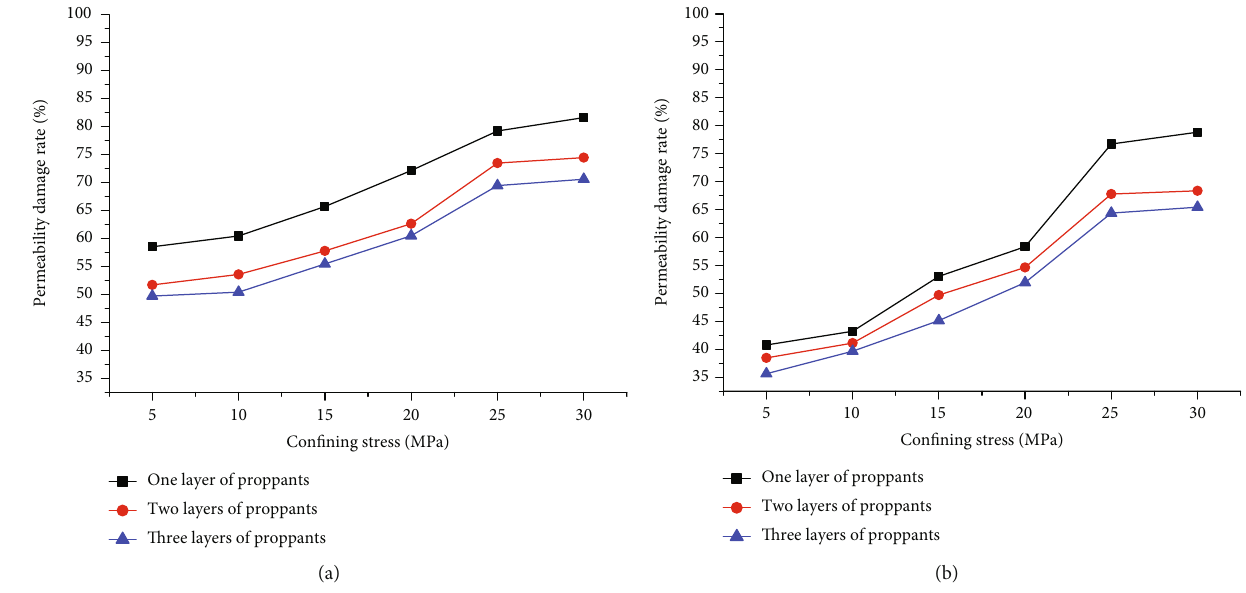
Figure 6: In fl uence of various proppant layers on permeability damage rate. (a) Permeability damage rate before brine fl ushing. (b) Permeability damage rate after brine fl